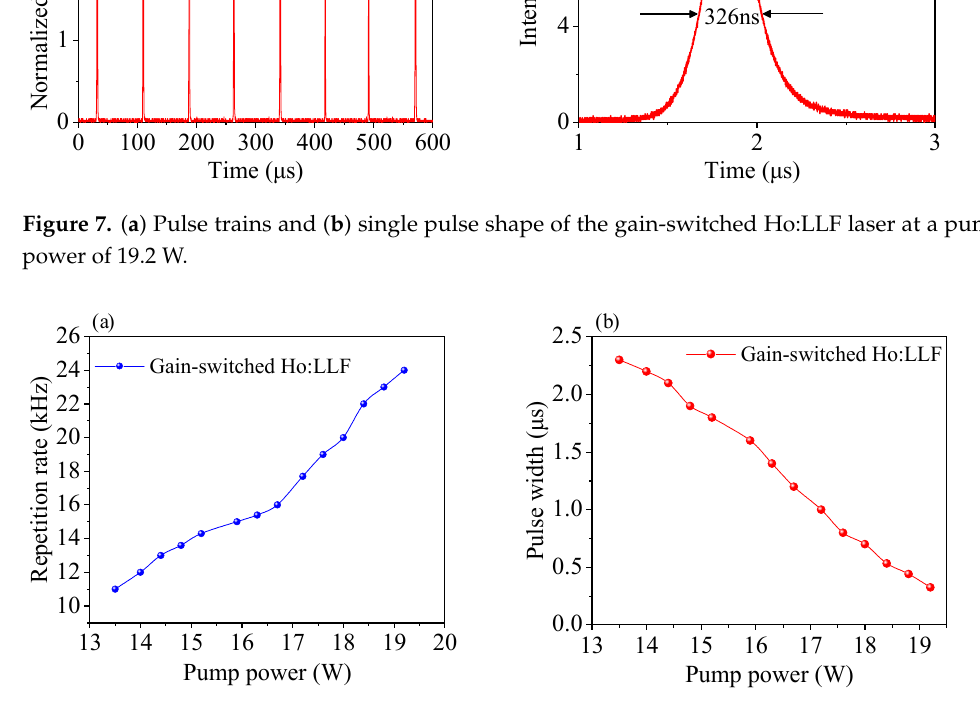
Figure 8. ( a ) Repetition rate and ( b ) temporal profile of the gain-switched Ho:LLF laser as a function of pump power.